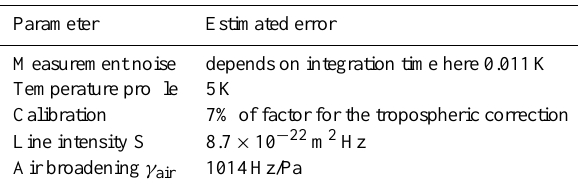
Table 2. Estimates of the errors of the relevant forward model